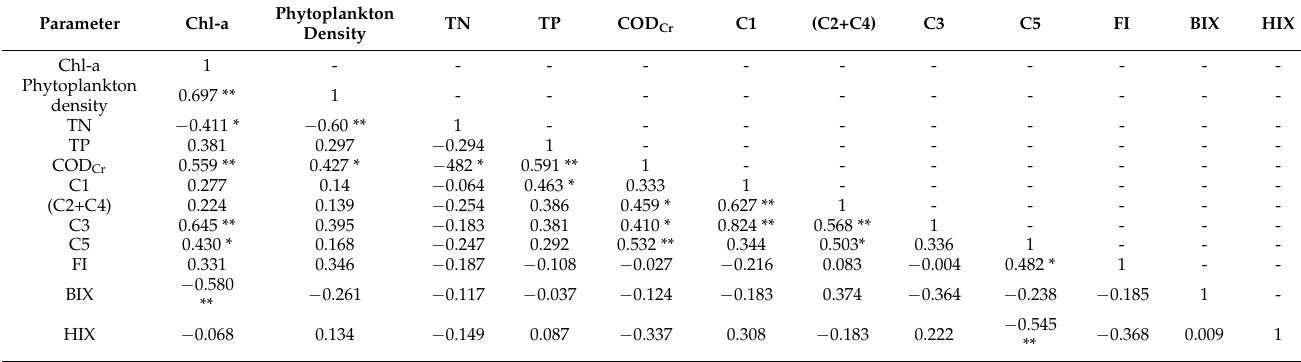
Table 4. Correlation coefficients between DOM components and environmental factors. “*” indicates p < 0.05, “**” indicates p <